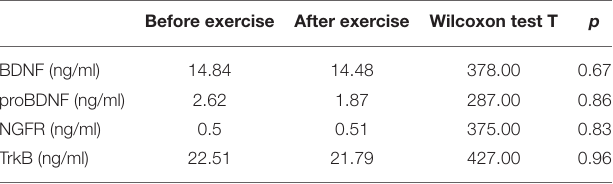
TABLE 3 | The table shows the time (in seconds) to complete the individual parts of the Stroop test (SCWT A—version A, monochrome and SCWT B—version